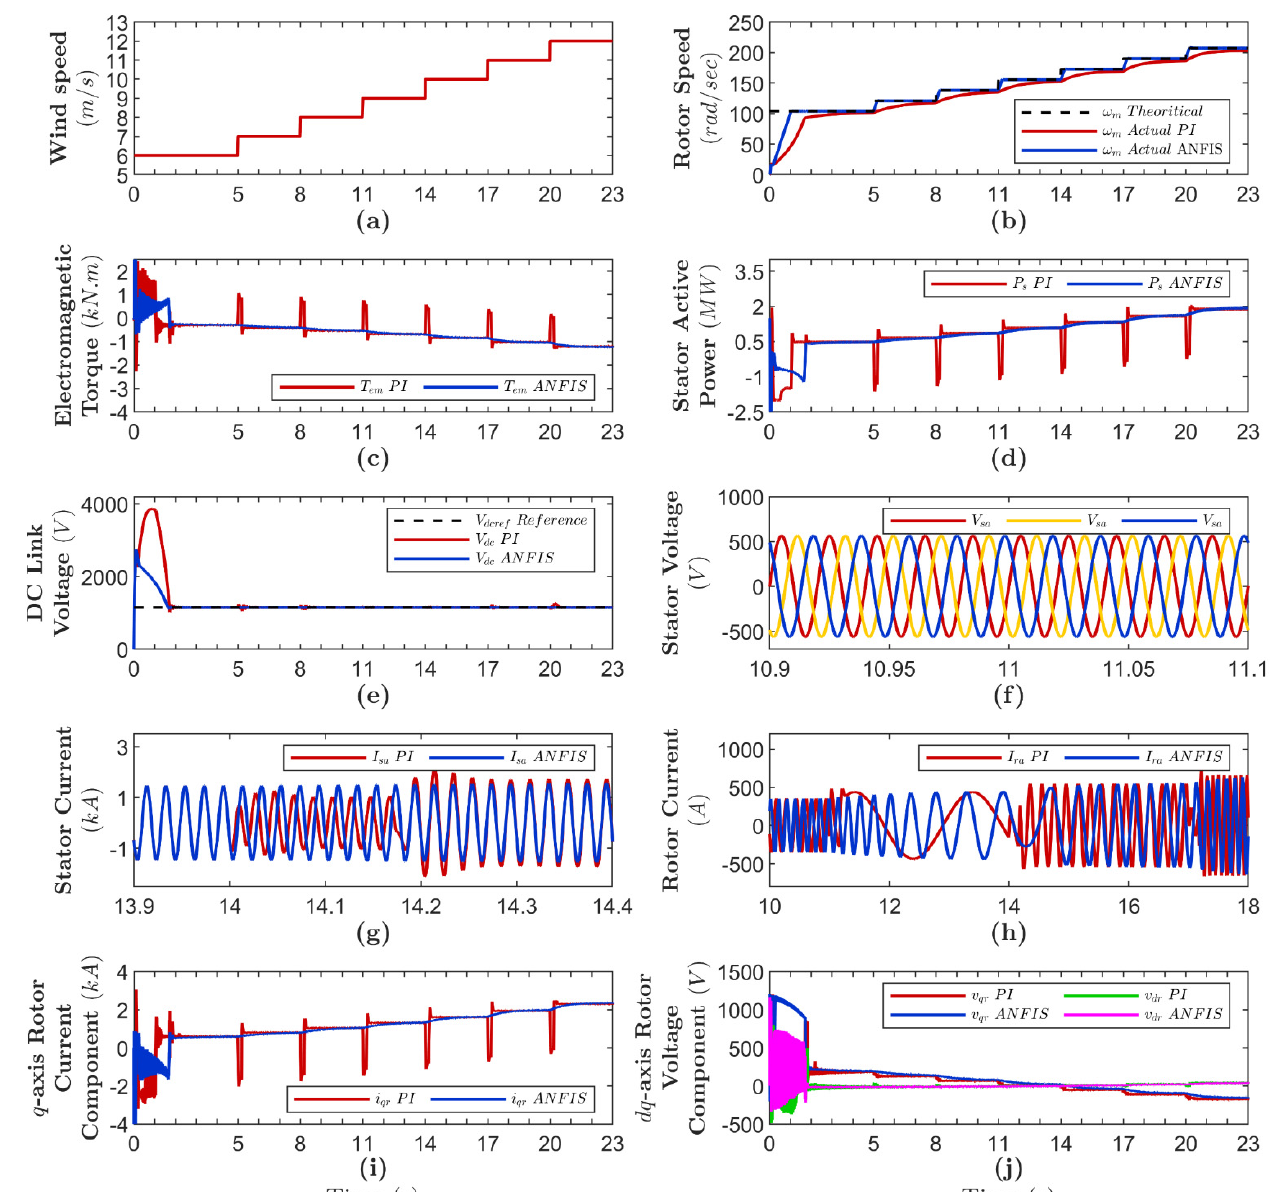
Figure 12. Simulated response under step wind speed increase: ( a ) input wind speed, ( b ) rotor speed, ( c ) electromagnetic torque, ( d ) stator active power, ( e ) DC-link voltage, ( f ) stator voltage, ( g ) stator current of a-phase, ( h ) rotor current of a-phase, ( i ) q -axis rotor current component, and ( j ) d and q axis rotor voltage component.